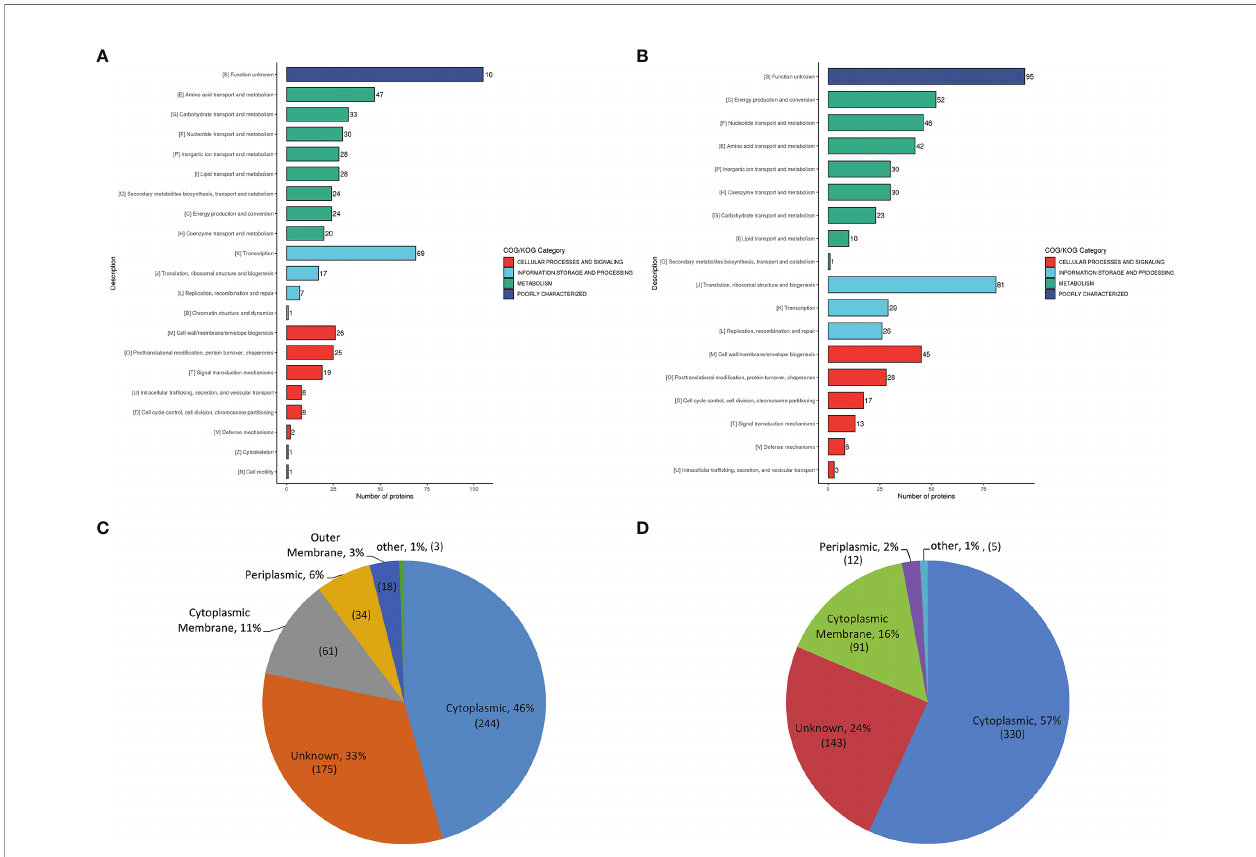
FIGURE 1 | COG and subcellular location analysis of DEPs. (A, B) , the histogram displaying COG analysis of upregulated (A) and down-regulated (B) DEPs in A19BG. Letters displayed in the abscissa represent individual COGs with the numbers of proteins listed in brackets afterwards. (C, D) , Annotated classi fi cation of subcellular structures of upregulated (C) and down-regulated (D) DEPs in